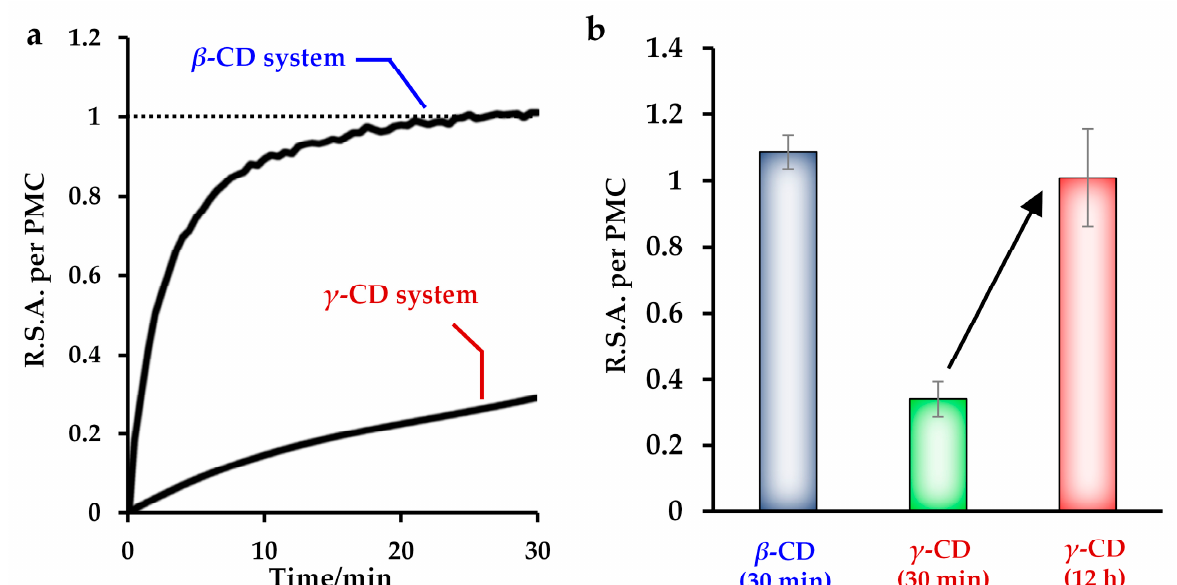
Figure 4. Results of the ABTS radical scavenging test for sample I. ( a ) Time dependence measurement and ( b ) radical scavenging ability (RSA) after 12 h and 30 min for the γ -cyclodextrin (CD)-added systems. The β -CD and γ -CD concentrations were diluted from 10 mM and 30 mM for the test, respectively, and the measurement was performed for the CD concentrations below 0.8 mM.